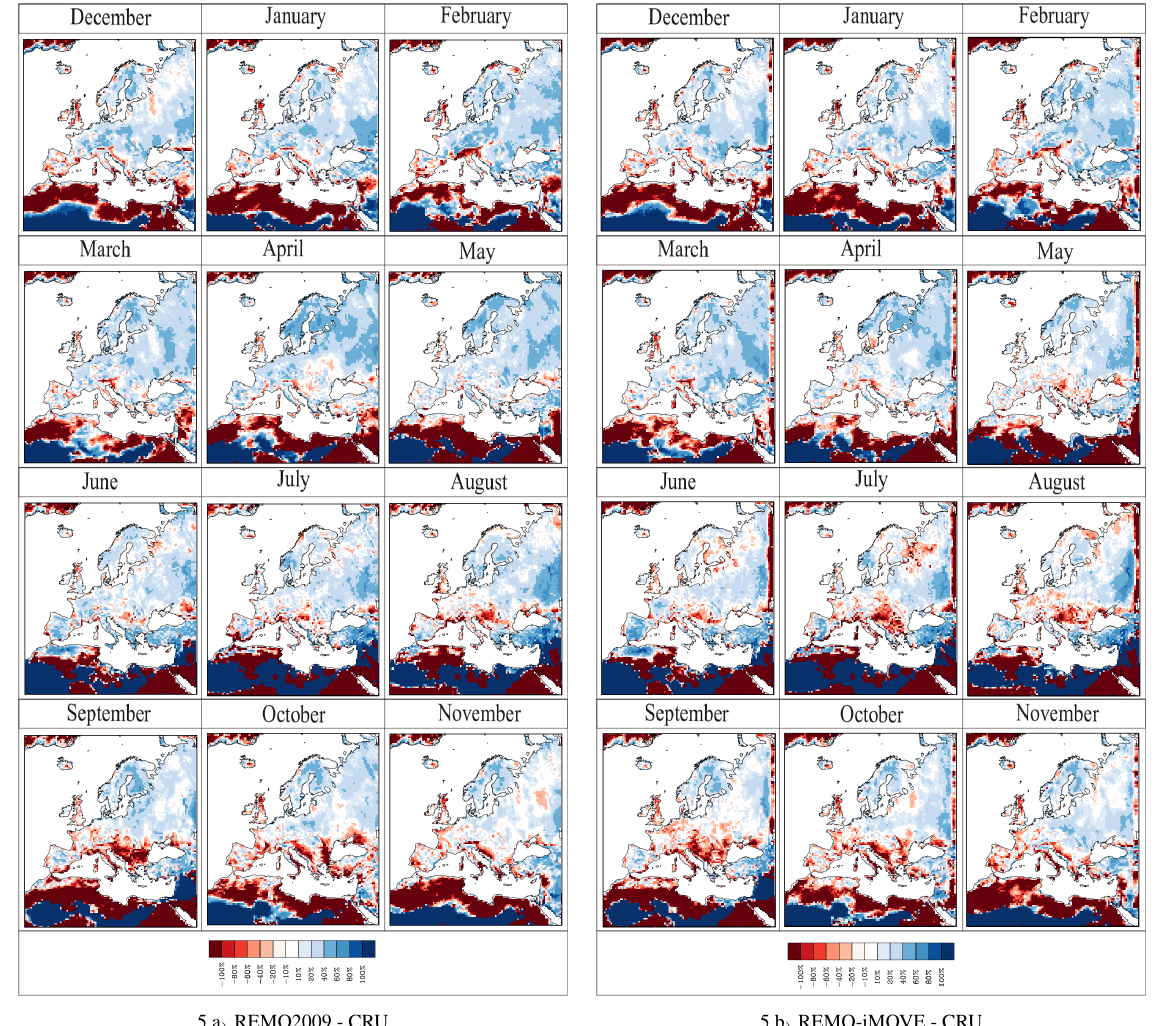
Figure 5. Differences of total precipitation of REMO2009 vs. CRU and REMO-iMOVE vs. CRU in the period 1996 to 2005